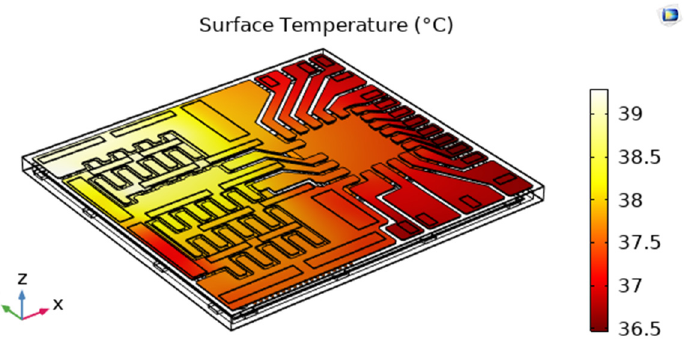
Figure 9. Temperature distribution inside the package. Temperature swing is equal to around 20 °C.